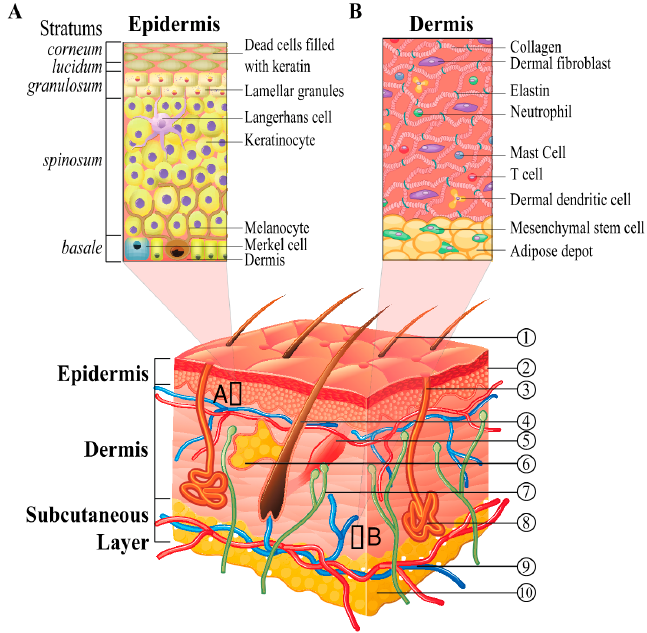
Figure 1. Skin Structure. The skin is composed of 3 main layers-Epidermis, Dermis and Subcutaneous layers containing (1) hair shaft; (2) stratum corneum; (3) sweat-pore; (4) hair follicle; (5) arrector pili muscle; (6) sebaceous gland; (7) nerve; (8) eccrine sweat gland; (9) cutaneous vascular plexes; (10) adipose depot. Detailed structure of ( A ) epidermis is shown with the stratum layers and ( B ) cellular composition and dermis is shown.